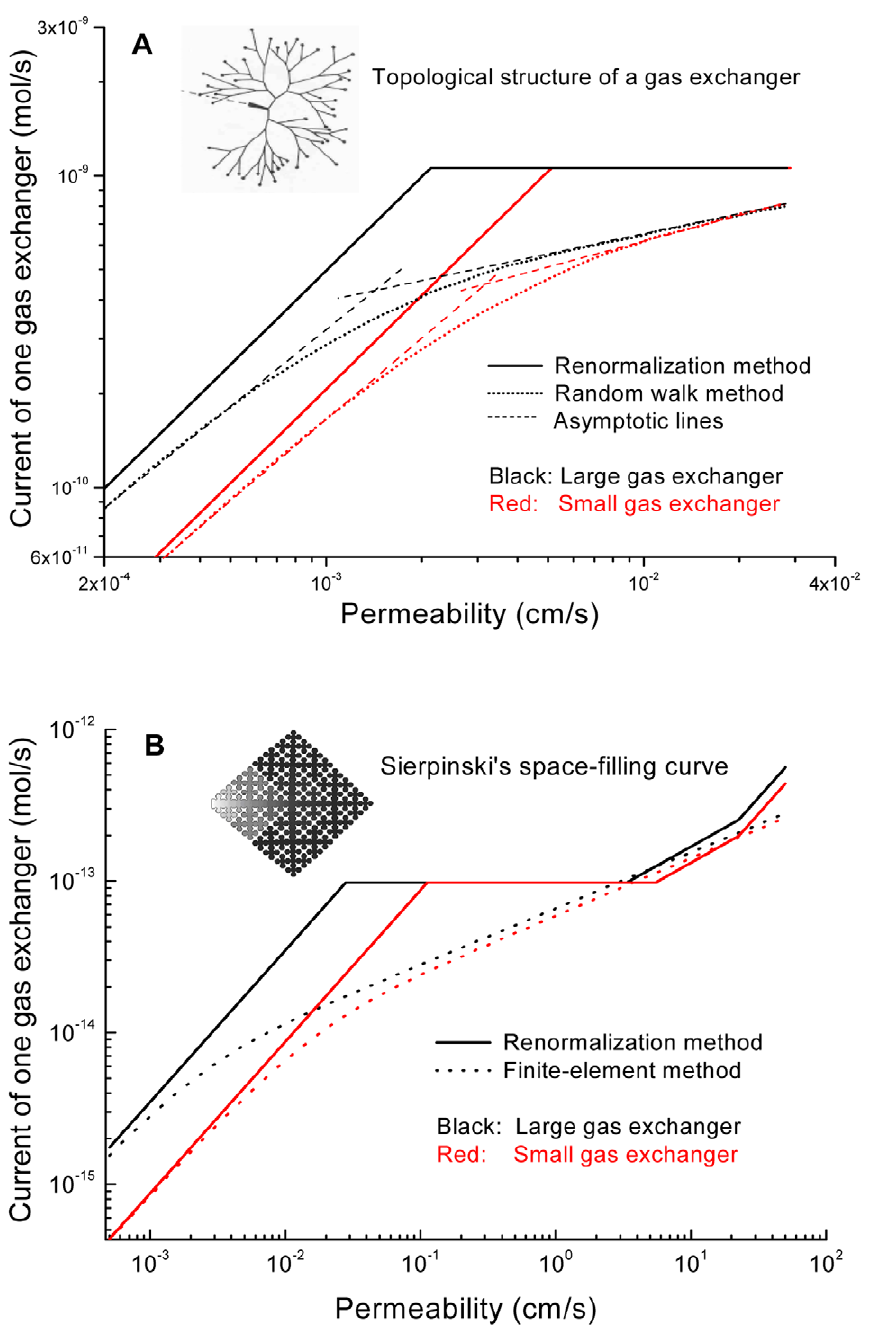
Figure 6. O 2 currents, at rest, across other gas-exchanger models. (A) Random-walk computations for largest and smallest specimen of eight 1/8 human acini, modeled as network of acinar ducts [21,22]. (B) Finite-element computations for Sierpinski’s plane-filling curves [32], as planar models of a 1/8 and 1/128 acinus ( D f =2, [4]). Both panels also show the respective currents from the renormalization method. Inset in (B): concentration field, ( c (x) 2 c b b a / b ,)/( c a 2 c b b a / b ,), in the 1/8 acinus (column 2 of Table 2). dynamic details of what happens at the transition between patterns. In the stationary diffusion-reaction framework, Equa- convection and diffusion. Upstream of the transition, velocity tions 2, 3, these flow patterns are averaged out, and the average vectors point mostly downstream, along the duct axis; down- yields the boundary condition at the source, Equation 2b. One stream of the transition, velocity vectors point mostly transverse may view the flow patterns as fluctuations around the stationary to the duct axis (diffusion to duct wall). In the transition region, average and examine their effect on the gas exchange. From the some velocity vectors point along the duct axis, others transverse perspective of length scales, the effect is minimal: a typical eddy to the duct axis, giving rise to eddy-like instantaneous flow has a diameter of 0.005–0.01 cm [25,26], which is small